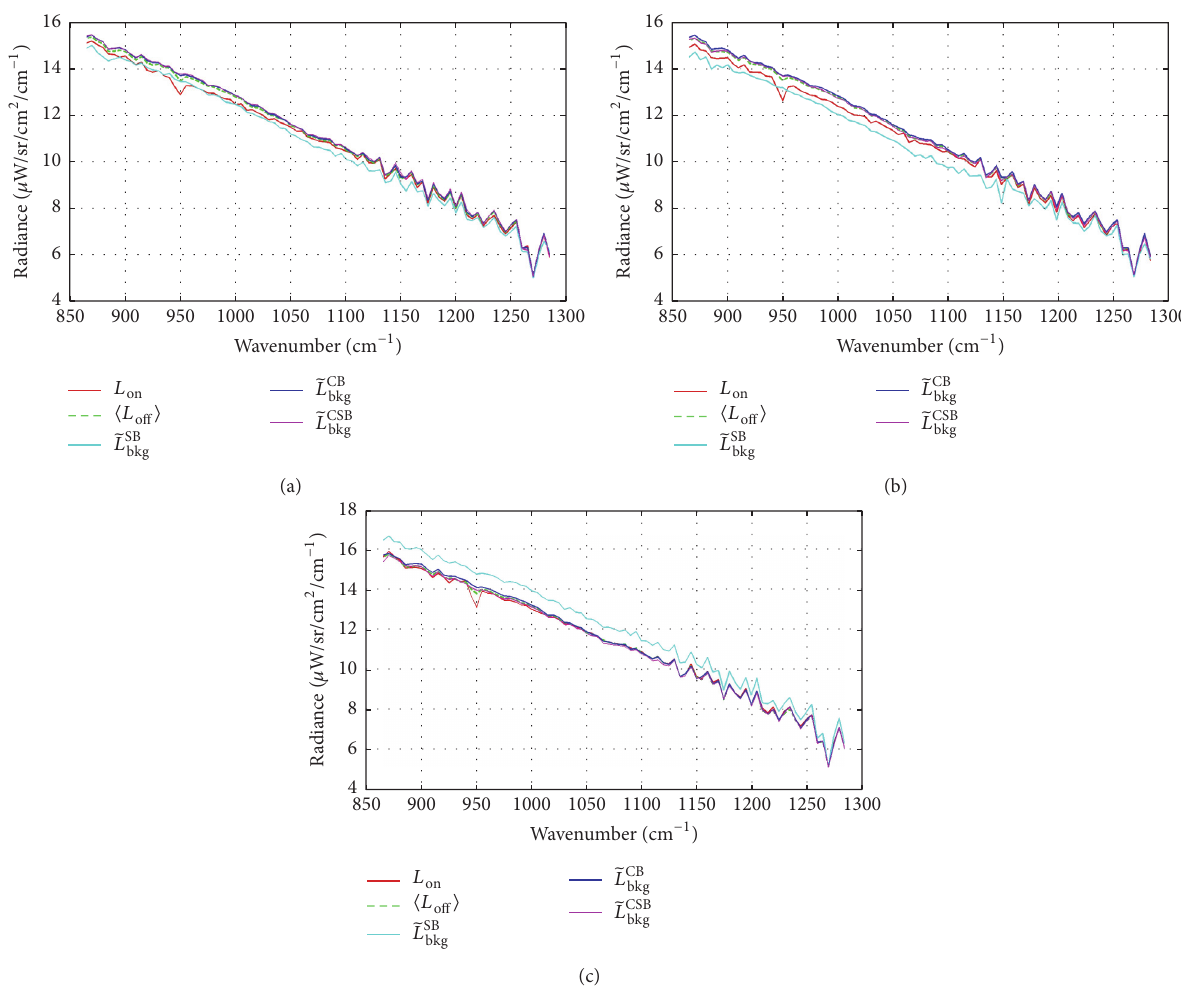
Figure 15: Comparison of background radiance estimation methods, for three different pixels through the plume. The red curves stand for the on-plume radiances; the dashed green ones are the expected background radiances. The cyan, blue, and magenta curves represent, respectively, the background radiance estimated by the SB, CB, and CSB methods. (a) Results for pixel 1, (b) results for pixel 2, and (c) results for pixel 3.